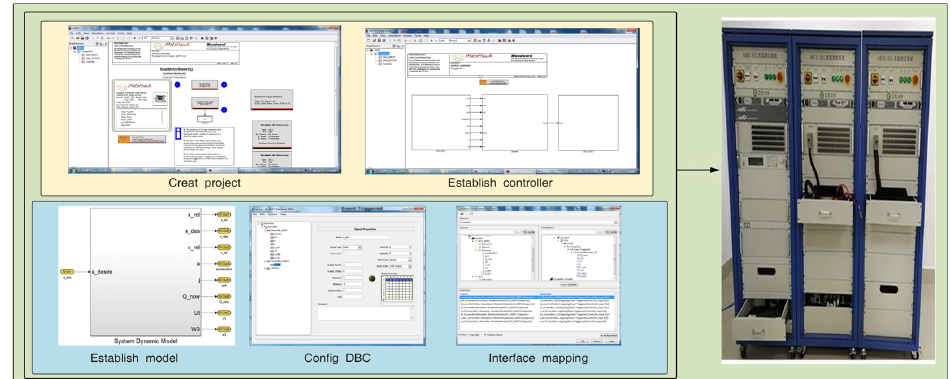
Figure 20. Schematic diagram of HIL test platform.